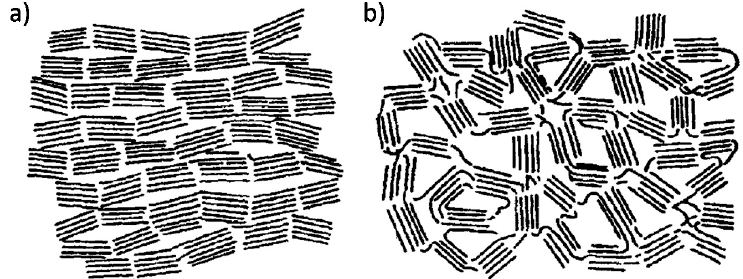
Figure 1. Schematic models for the microstructure of graphitizable carbons ( a ) and non- graphitizable carbons ( b ). Reproduced from [25] with permission of The Royal Society (UK) © 1951.